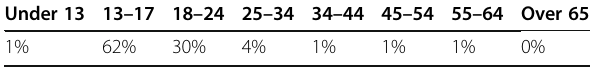
Table 3 Ages of